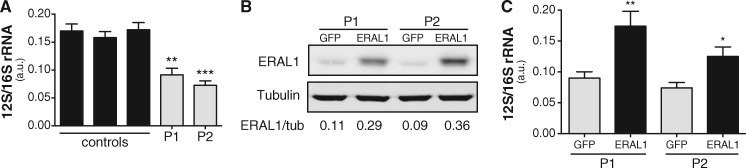
12S rRNA levels are decreased in PS cells and are rescued after ectopic
ERAL1 expression. (A) The 12S to 16S rRNA ratio in
control and PS fibroblasts as measured by qPCR. Both patients present with
significantly lower 12S/16S rRNA ratio compared to controls. Data are represented as
the mean±SEM of six biological replicates. **p<0.01, ***p<0.001 as calculated by
a one-way ANOVA Tukey's multiple comparisons test. (B) Western blot from
PS fibroblasts infected by GFP or ERAL1 overexpressing lentivirus.
Patient cells infected with ERAL1 overexpressing lentivirus stably express ERAL1
protein compared to those infected by a GFP overexpressing virus. Quantification of
the levels of ERAL1 normalized to tubulin are given below the blot. (C)
12S to 16S rRNA ratio in PS fibroblasts stably expressing ERAL1 or
GFP. Patient cells stably expressing ERAL1 present a significantly
increased 12S/16S rRNA ratio compared to those expressing GFP, that almost reaches the
levels of healthy cells (panel A). Data are represented as the mean±SEM of six
biological replicates. *p<0.05, **p<0.01 as calculated by a 2-tailed student’s
t-test.